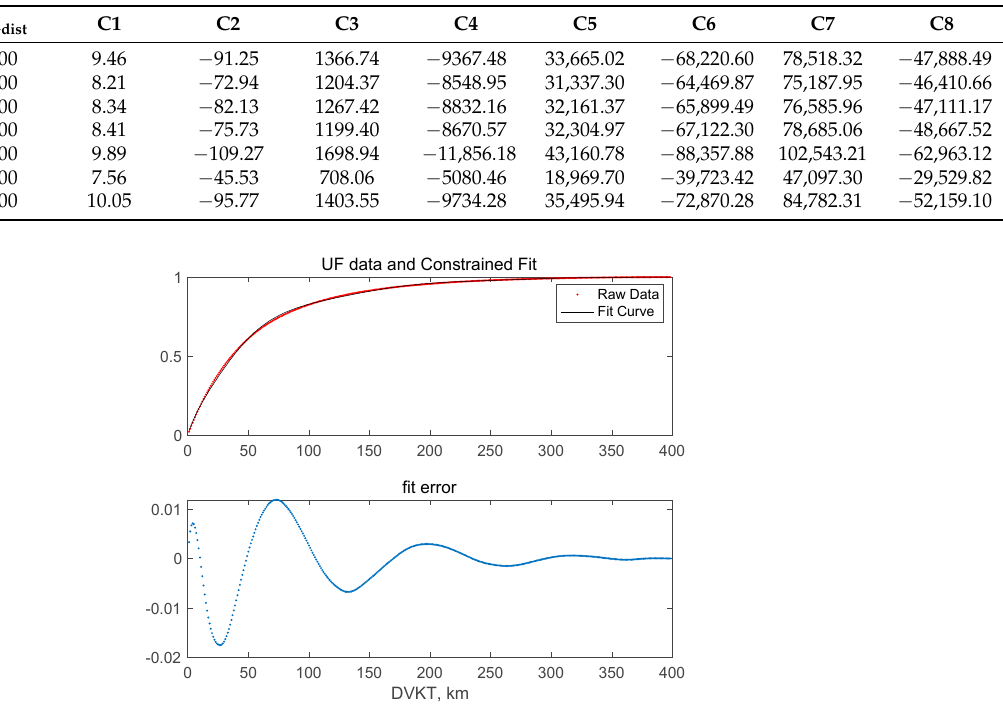
Figure 5. UF fitting error illustration (Beijing).